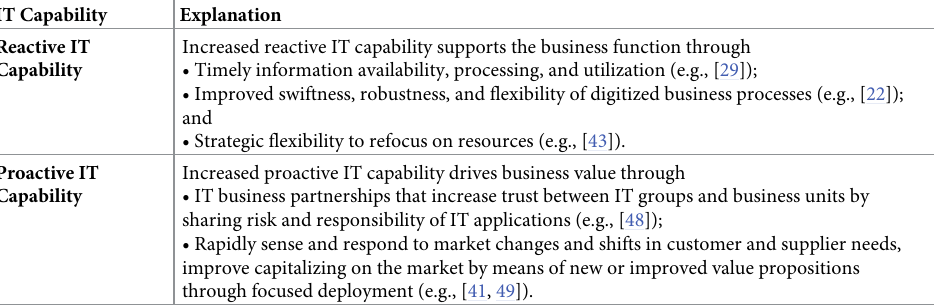
Table 2. Explanations for the relationship between IT capability and organizational